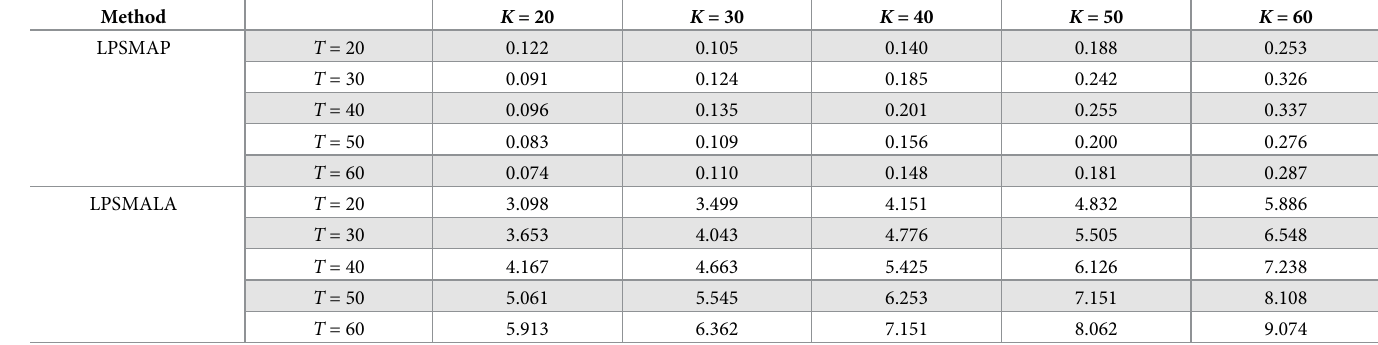
Table 5. Computational time (real elapsed time in seconds) of LPSMAP and LPSMALA (with a chain length of 3 000) for different combinations of T (total number of days of the epidemic) and K (total number of B-splines in the basis). EpiLPS algorithm running on an Intel Xeon E-2186M CPU @2.90GHz with 16Go RAM.